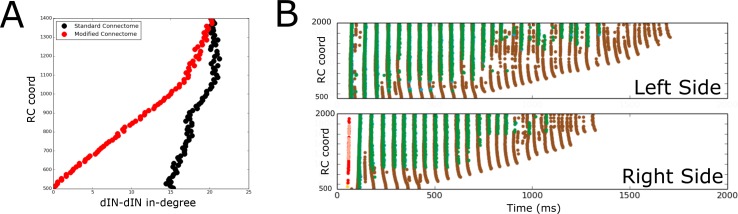
Comparison of spiking activity in the normal case and when dIN ascending axons are removed.(A) Average in-degree from dINs to other dINs at different rostro-caudal positions in the standard connectome (black dots) and after removal of ascending dIN axons (red dots). (B) Example of typical spiking activities from connectomes with ascending dIN axons removed (case 1, see text for details).